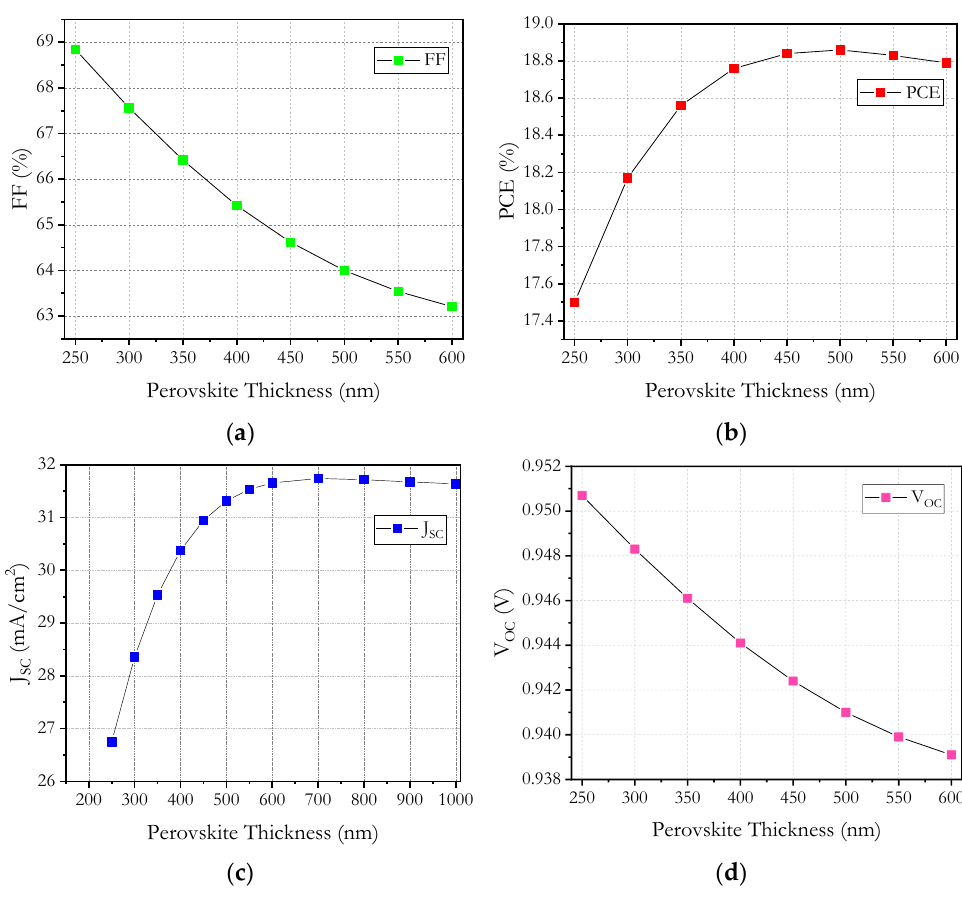
Figure 7. Absorber layer thickness versus ( a ) FF , ( b ) PCE , ( c ) J sc and ( d ) V oc .